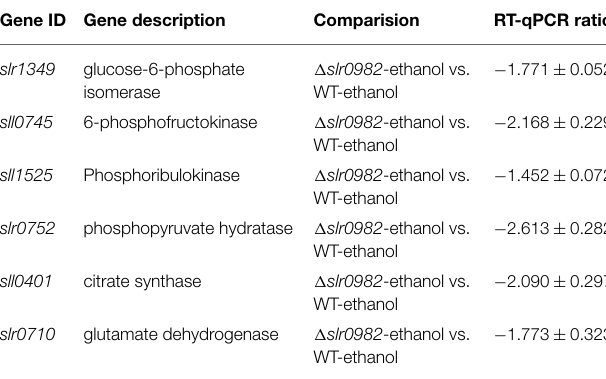
TABLE 1 | RT-qPCR analysis of selected